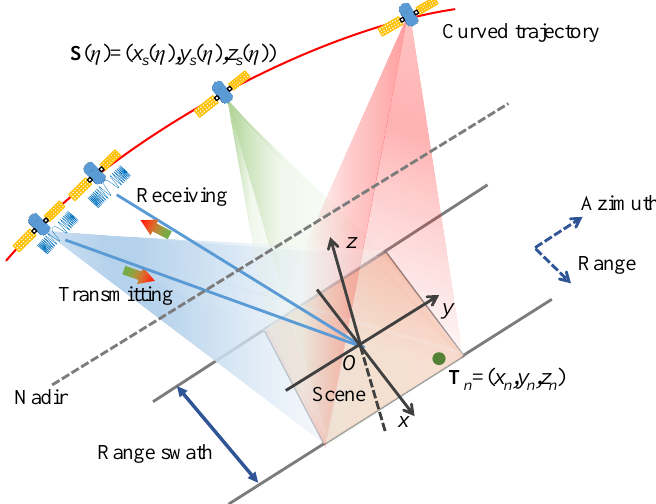
Figure 1. The geometry of spotlight mode with right